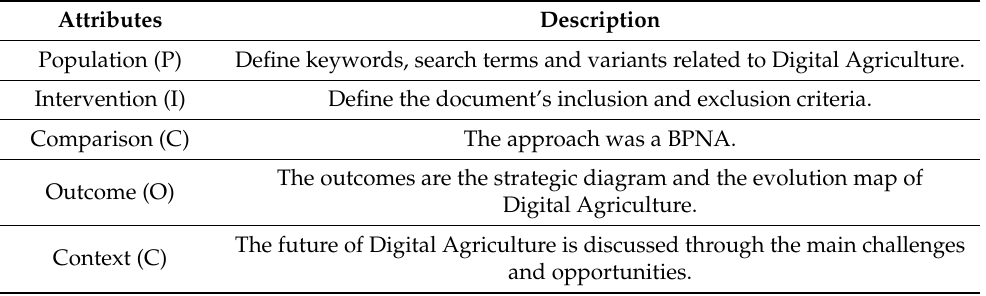
Table 1. Steps defined according to the PICOC protocol.